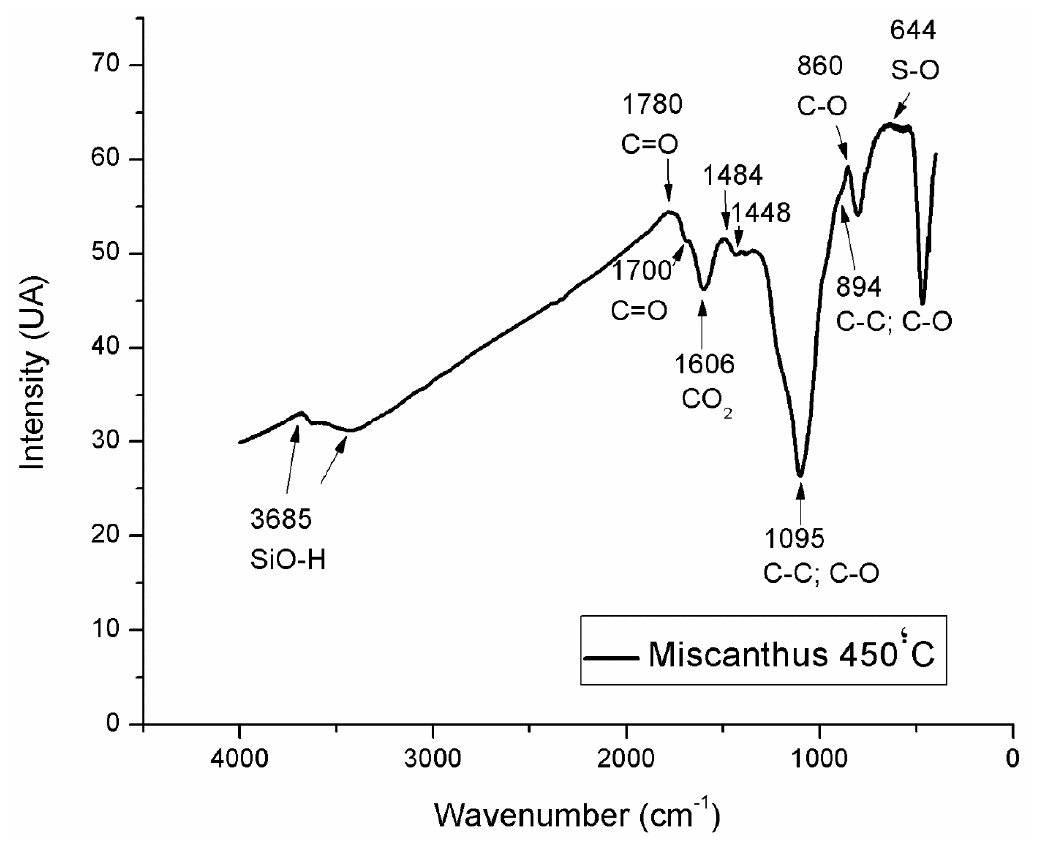
Figure 1. Fourier transform infrared spectrum of Miscanthus biochar pyrolyzed at 450 °C.